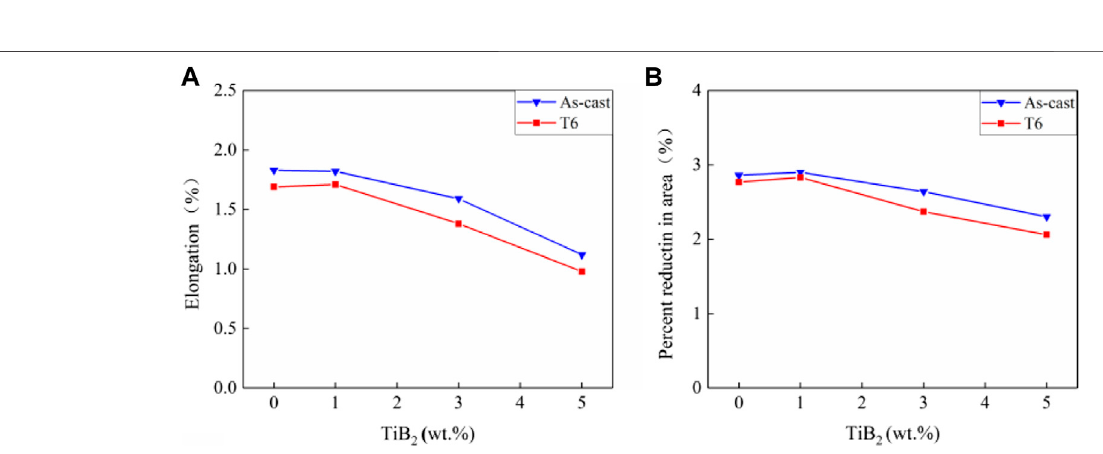
Frontiers in Materials |